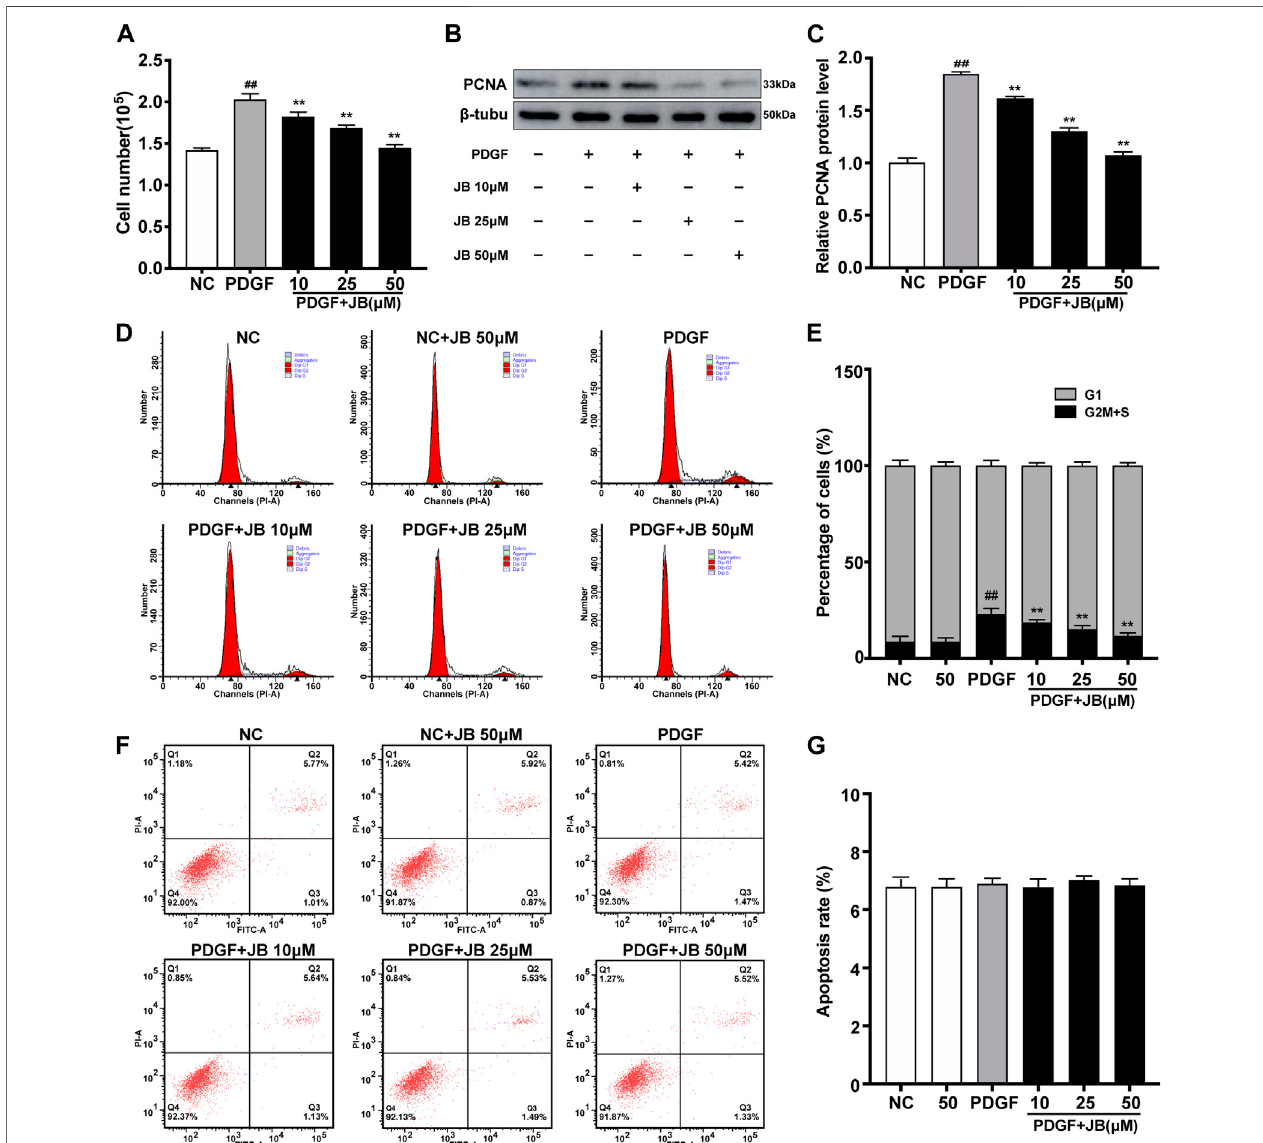
FIGURE4| JBinhibitedtheproliferationofVSMCsinducedbyPDGF-BB.VSMCswereincubatedwithPDGF-BBinthepresenceofdifferentconcentrationsofJB. (A) EvaluationoftheproliferationofVSMCsbydirectcellcounting. (B) WesternblottinganalysisofPCNAproteinexpression. (C) Quanti fi cationoftherelativeproteinlevel ofPCNA. (D) RepresentativecellcycleimagesshowingthecellcycleprogressionofVSMCsbetweentreatmentgroups. (E) Quantitativeanalysisofcellcycledistribution ineachgroup. (F) DeterminationofAnnexin V-PIofVSMCs ineachgroup. (G) Quantitativeanalysisofthepercentageofapoptotic cellsby fl owcytometry.Dataare expressed as mean ± S.D. ## p < 0.01 vs. Control. ** p < 0.01 vs. PDGF-BB group. n (cid:1)